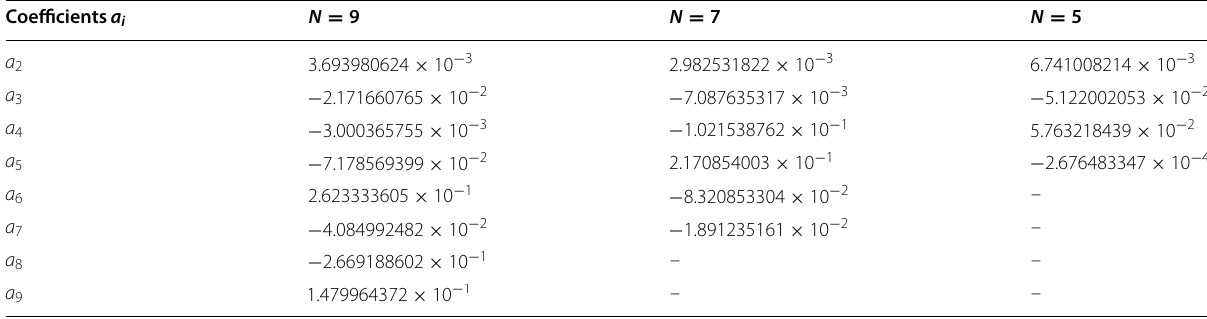
Table 9 Coefficients a i for various N of Rayleigh–Ritz procedure in case (3) Coefficients a